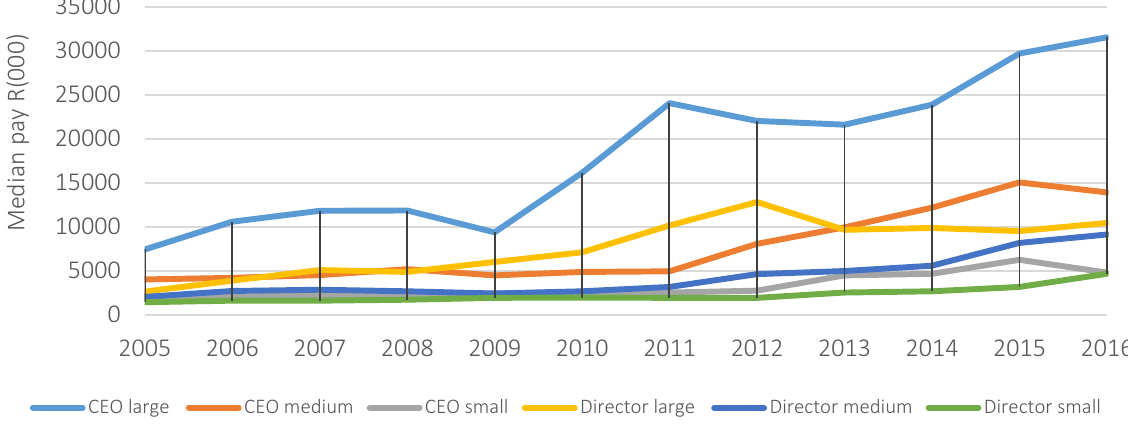
Figure 2. Evolution of median executive total pay